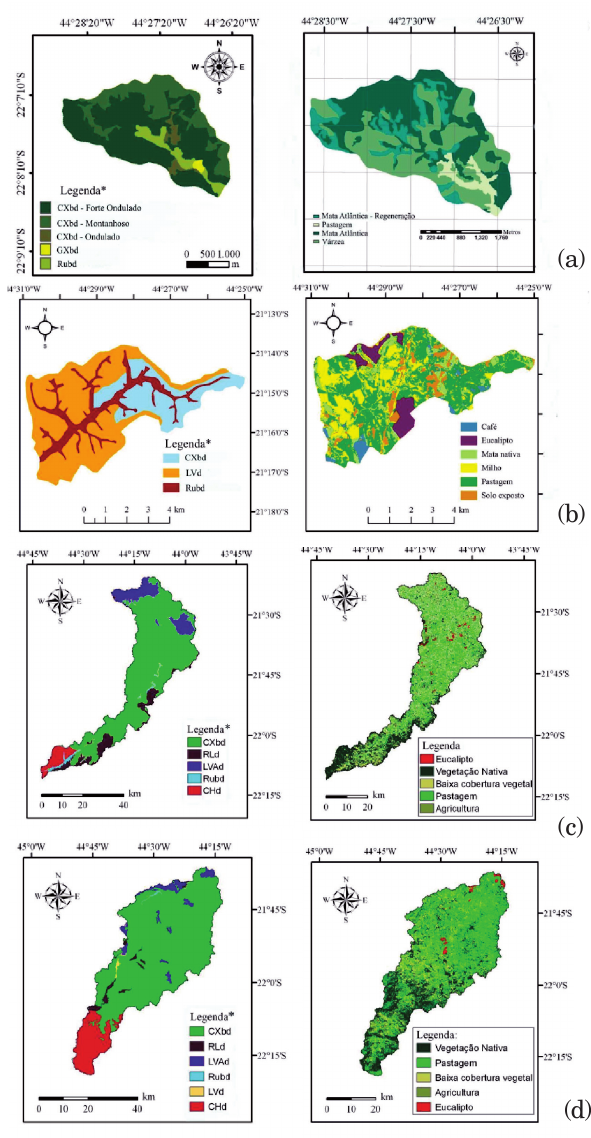
Figura 2. Mapas de solos (coluna à esquerda) e de uso dos solos (coluna à direita) para as sub- bacias hidrográficas dos ribeirões Lavrinha (a) e Jaguara (b) e rios Grande (c) e Aiuruoca (d). Adaptadas, respectivamente, de Beskow et al. (2009), Pinto (2011) e Viola (2011). * ver legenda da figura